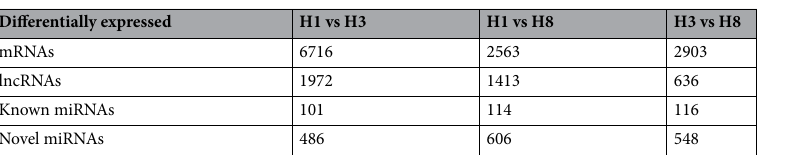
Table 2. Number of differentially expressed coding and non-coding genes identified from H1 vs H3, H1 vs H8 and H3 vs H8. H1 vs H3 = H1O1–H1O3 and H3O2–H3O4 represent 3 ovaries from 1 and 3 months old, respectively; H1 vs H8 = H3O2–H3O5 and H8O1–H8O3 represent 3 ovaries from 3 and 8 months old, respectively, and H3 vs H8 = H3O2–H3O5 and H8O1–H8O3 represent 3 ovaries from 3 and 8 months old,